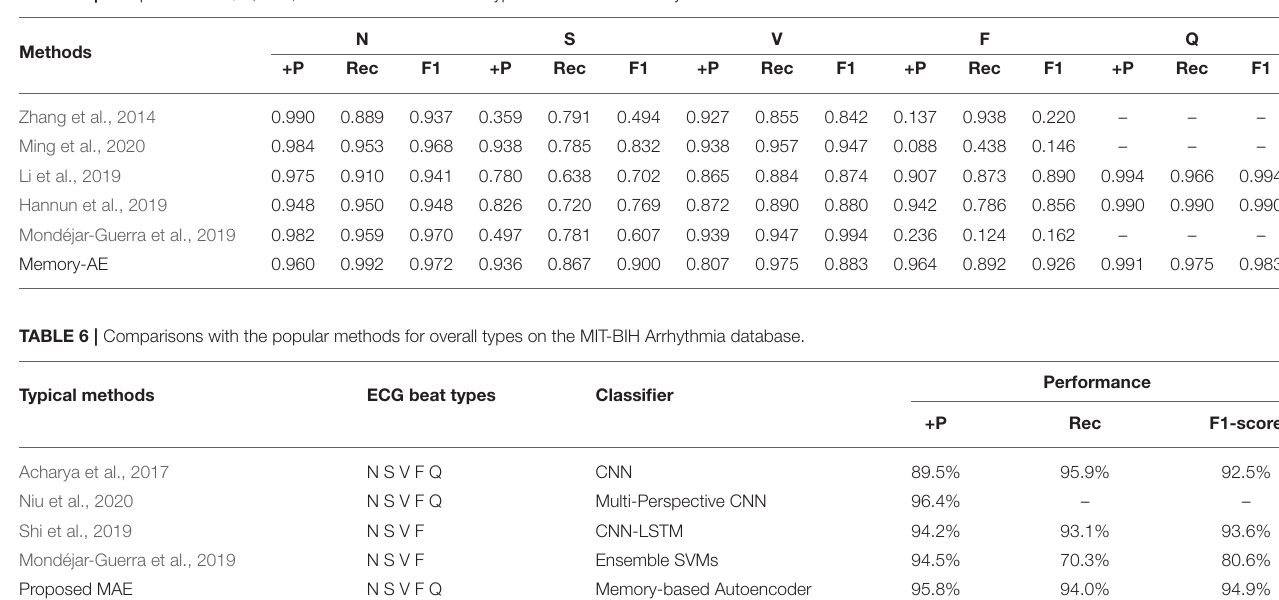
TABLE 5 | Comparisons of + P , Rec , and F 1 − score for each type on the MIT-BIH Arrhythmia database.